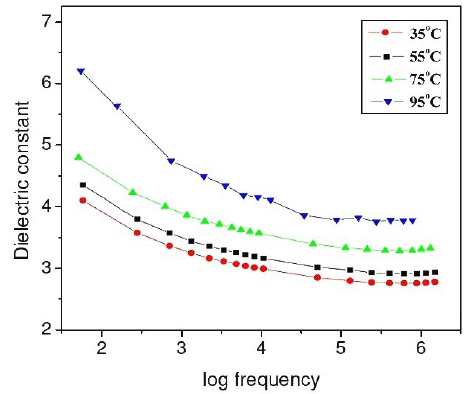
Fig.8. Dielectric constant with log frequency